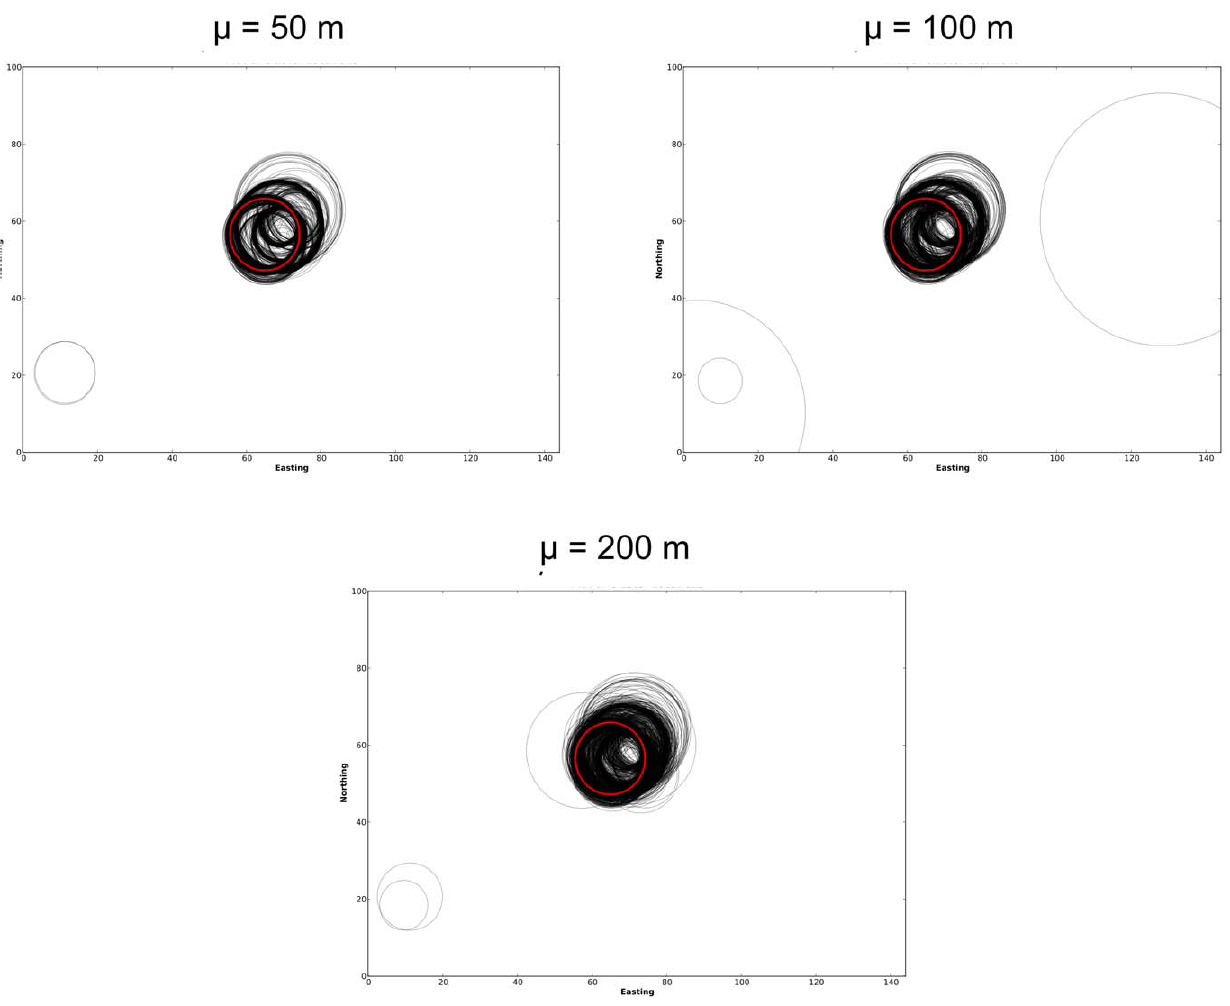
Figure 10. Plots of MLCs identified within the Mesa crime data using the STPSS. The spatial footprint of the MLC for the original dataset is shown in red. MLCs from perturbed versions of the same dataset are shown in black.